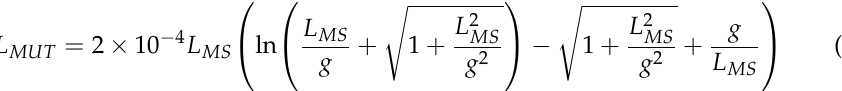
proposed microwave sensor are optimized (see Figure 3b), as shown in Table 1 (all unit values are